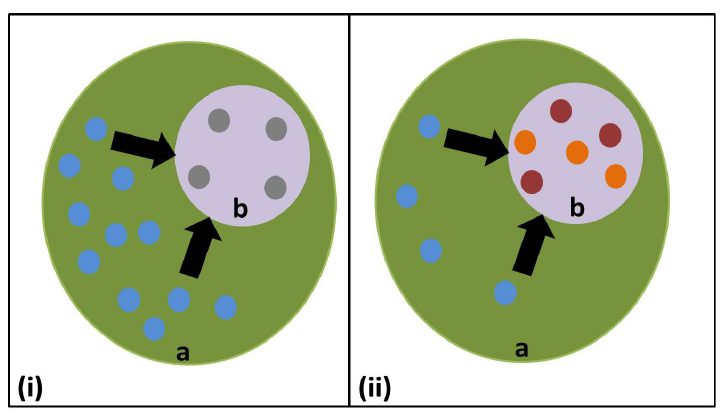
Figure 1: (i). Diagrammatic illustration of mosquito vectors expanding to new habitats within their natural range - (a): Existing natural habitats (blue solid circles) for preimaginal development; (b): Anthropogenic activities create new habitats (ash solid circles) for preimaginal development within the natural range of the mosquitoes. (ii). Diagrammatic illustration of anthropogenic activities eliminating existing habitats in the natural range of mosquito vectors leading to their adaptation to other less desirable habitats within their range - (a) Existing natural habitats (blue solid circles) for preimaginal development; (b) Mosquitoes adapting to other less desirable habitats (brown and orange solid circles) in their natural